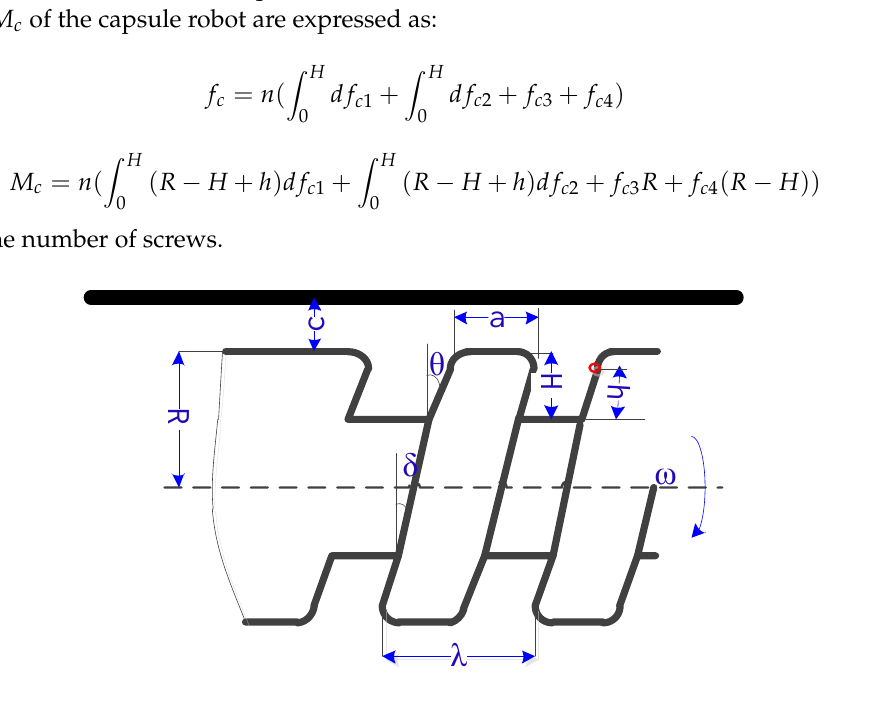
Figure 6. Geometrical parameters of the screw structure.